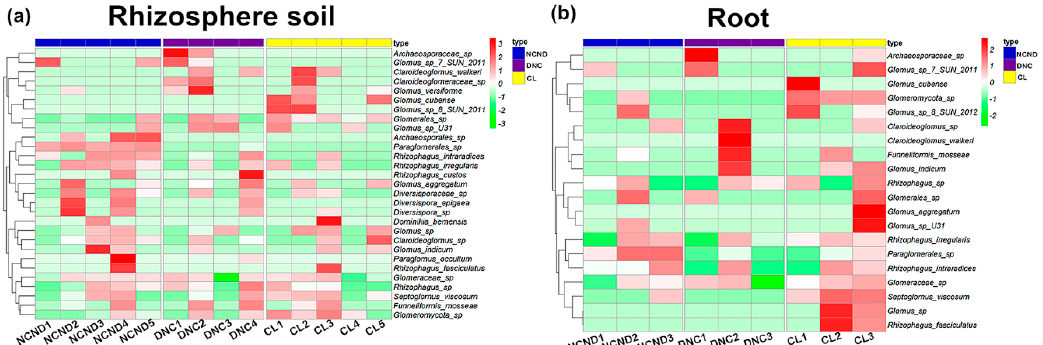
Figure 3. Heatmaps of top thirty relative abundances of arbuscular mycorrhizal fungus (AMF) indicating taxa were significantly differed in rhizosphere soils ( a ) and roots ( b ) of C. dactylon along the drawdown zone of the Three Gorges Reservoir. The 14 columns represent the individual sampling blocks in the NCND (non-cultivated non-disturbed land), DNC (disturbed non-cultivated land) and CL (cultivated land). The scale bar indicates the abundance of AMF taxa (-3 / -2 represents minimum, 3 / 2 represent maximum). Abbreviations: CL1: C . dactylon from CL; CL2: C . dactylon from CL; CL3: C . dactylon from CL; CL4: C . dactylon from CL; CL5: C . dactylon from CL; DNC1: C . dactylon